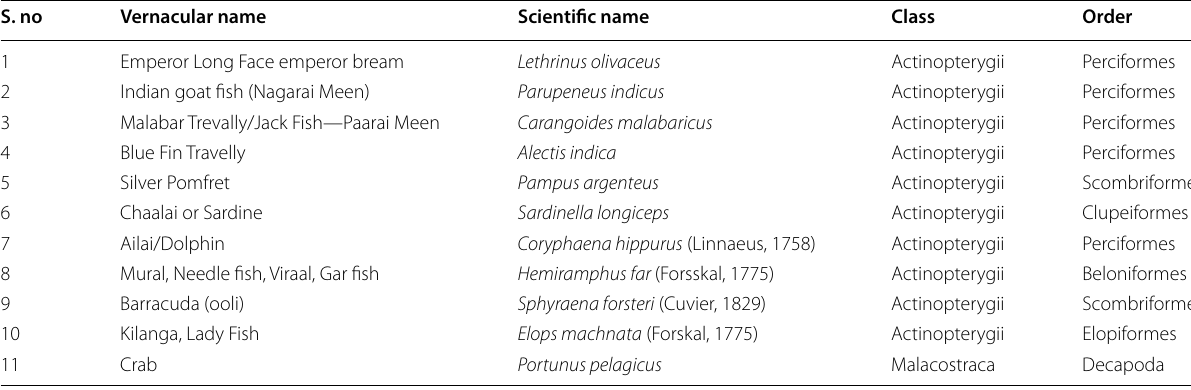
Table 1 List of fish collated to study the environmental risk assessment